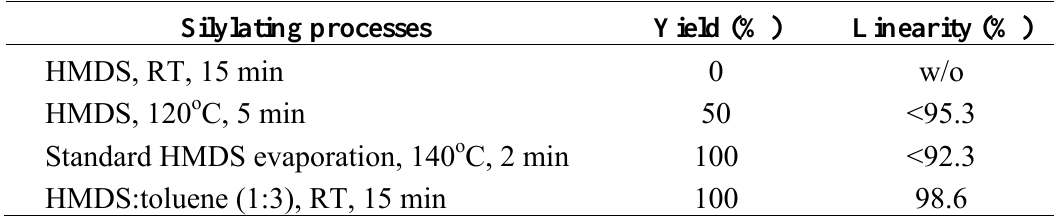
N -ISFETs (RT = room 3 4